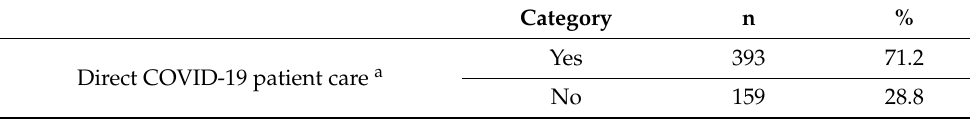
Table 3. Care of COVID-19 patients and impact of COVID-19 on healthcare practice.